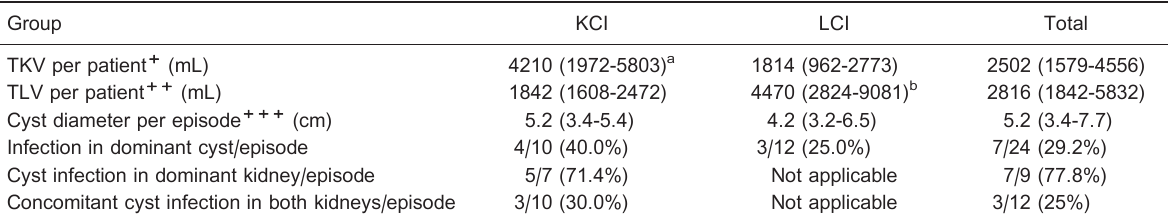
Data are reported as median with p25-p75 in parentheses or as number with percent in parentheses. TKV: total kidney volume; TLV: total liver volume; KCI: kidney cyst infection; LCI: liver cyst infection; p25-p75: 25 to 75 percentile. + An ADPKD patient with previous unilateral nephrectomy and 1 ADPLD subject were excluded from the TKV analysis. ++ The ADPLD patient was included in the TLV analysis. +++ The largest internal diameter of each infected cyst was measured by computed tomography. In each episode, when multiple cysts